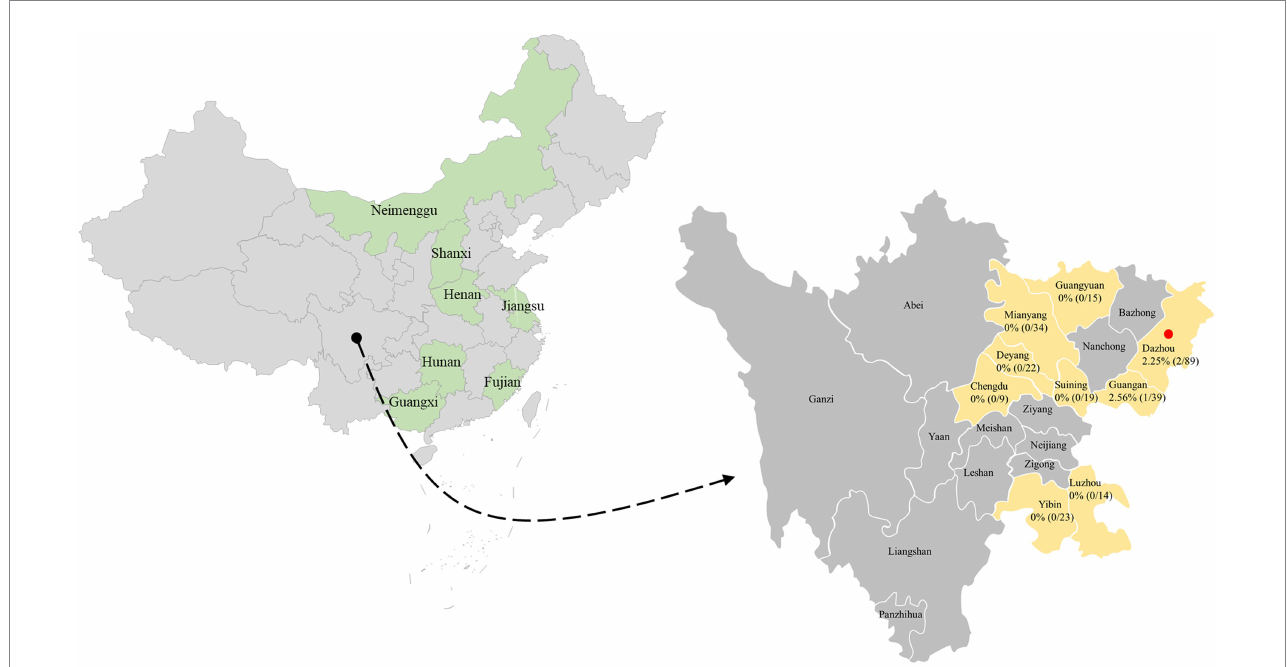
FIGURE 1 The geographical distribution of the 264 samples. In China, the provinces with PCV4 identification were filled with light green. The clinical samples in this study were collected from light gold-filled cities in southwestern China, and cities with positive samples were marked by red solid circles. The numbers indicate the positivity rate of PCV4 in different